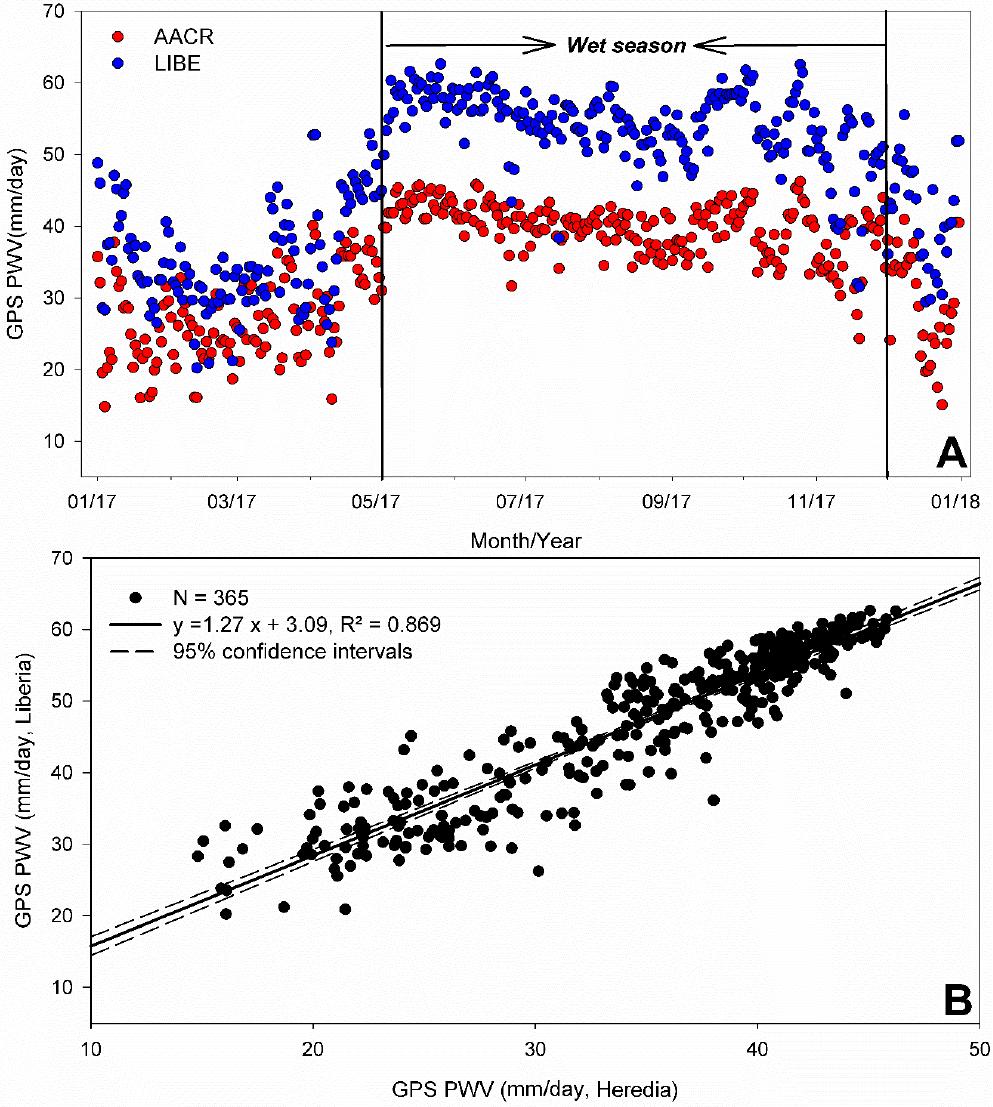
Figure 5. ( A ) The time series of GPS precipitable water vapor (PWV) (mm / day) estimated for AACR (blue circles) and LIBE (red circles): The wet season period 2017 (May–November) is delimited in the graph. ( B ) The graph shows the relationship between the GPS PWV estimated for ACCR and LIBE (p < 0.001, N = 365). The 95% confidence limits are also shown (dashed lines).